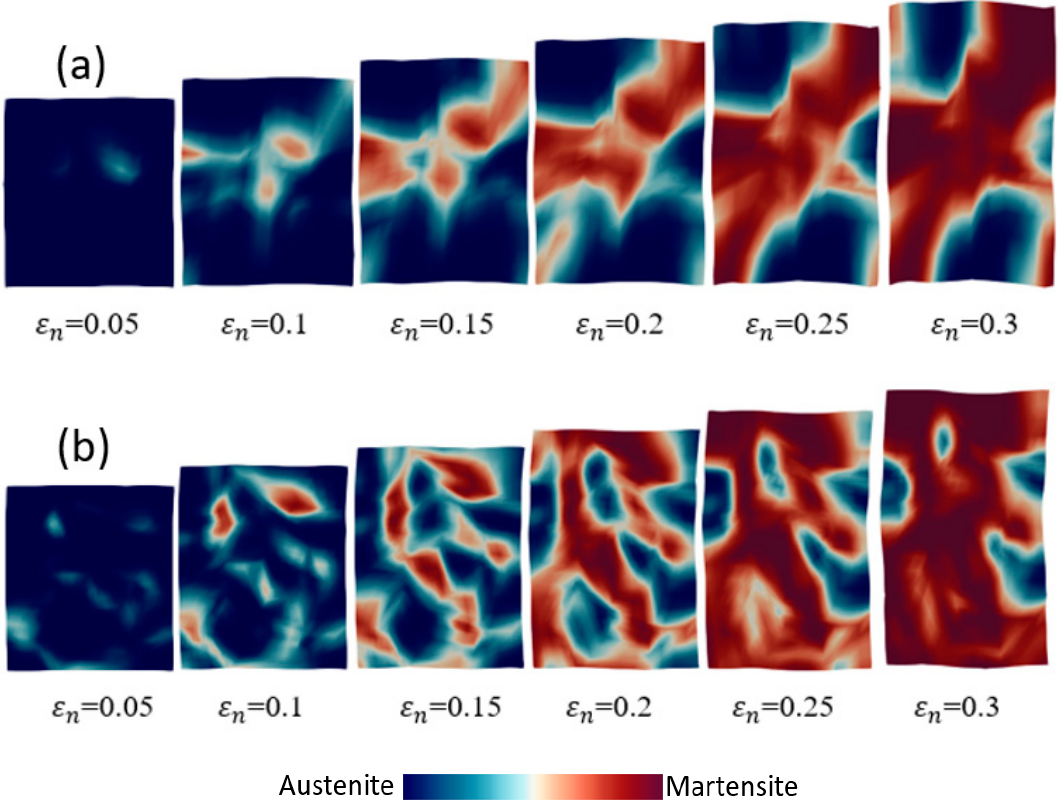
Figure 11. The distribution of martensitic phase of ( a ) 4-grain and ( b ) 14-grain polycrystal TRIP steel with random initial crystal orientations.